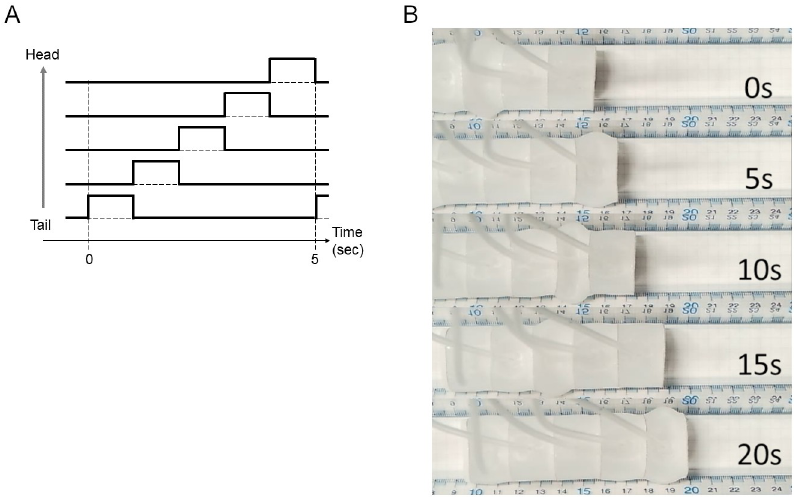
Fig 8. Performance of the soft robots. (A) Schematic of the control signal for the soft robot to drive forward crawling. (B) Still images of soft robot locomotion. The soft robot crawls from left to right.